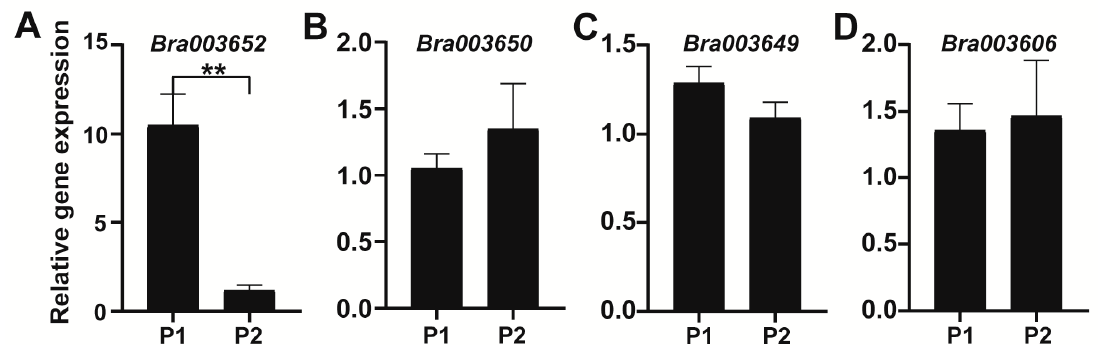
Figure 6. The expression patterns of candidate genes in the hypocotyl from P1 (turnip) and P2 (Chinese cabbage). Values are the mean ± SD of three biological replicates. ** significantly different at p < 0.01.